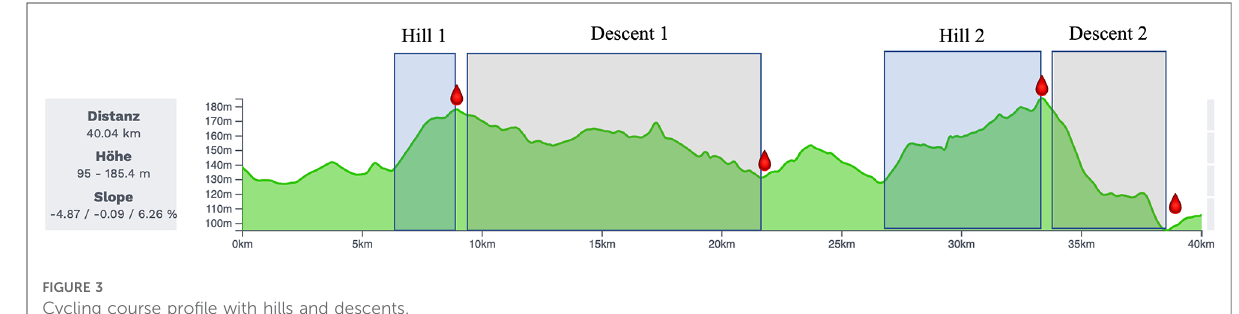
FIGURE 3 Cycling course pro fi le with hills and